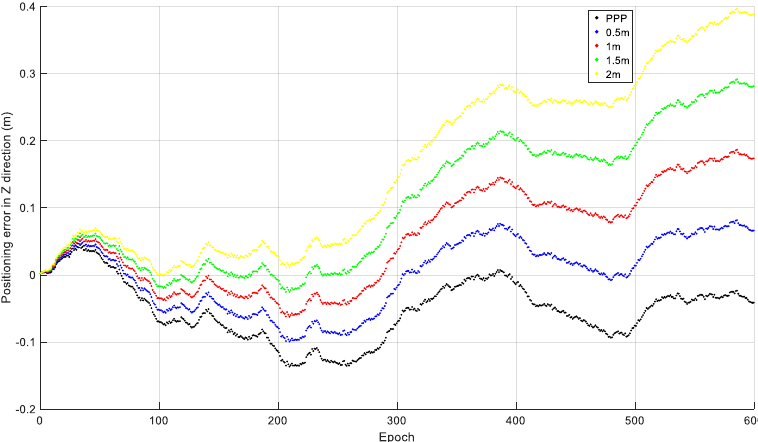
Figure 5. Positioning error in the Z direction with different initial coordinates.